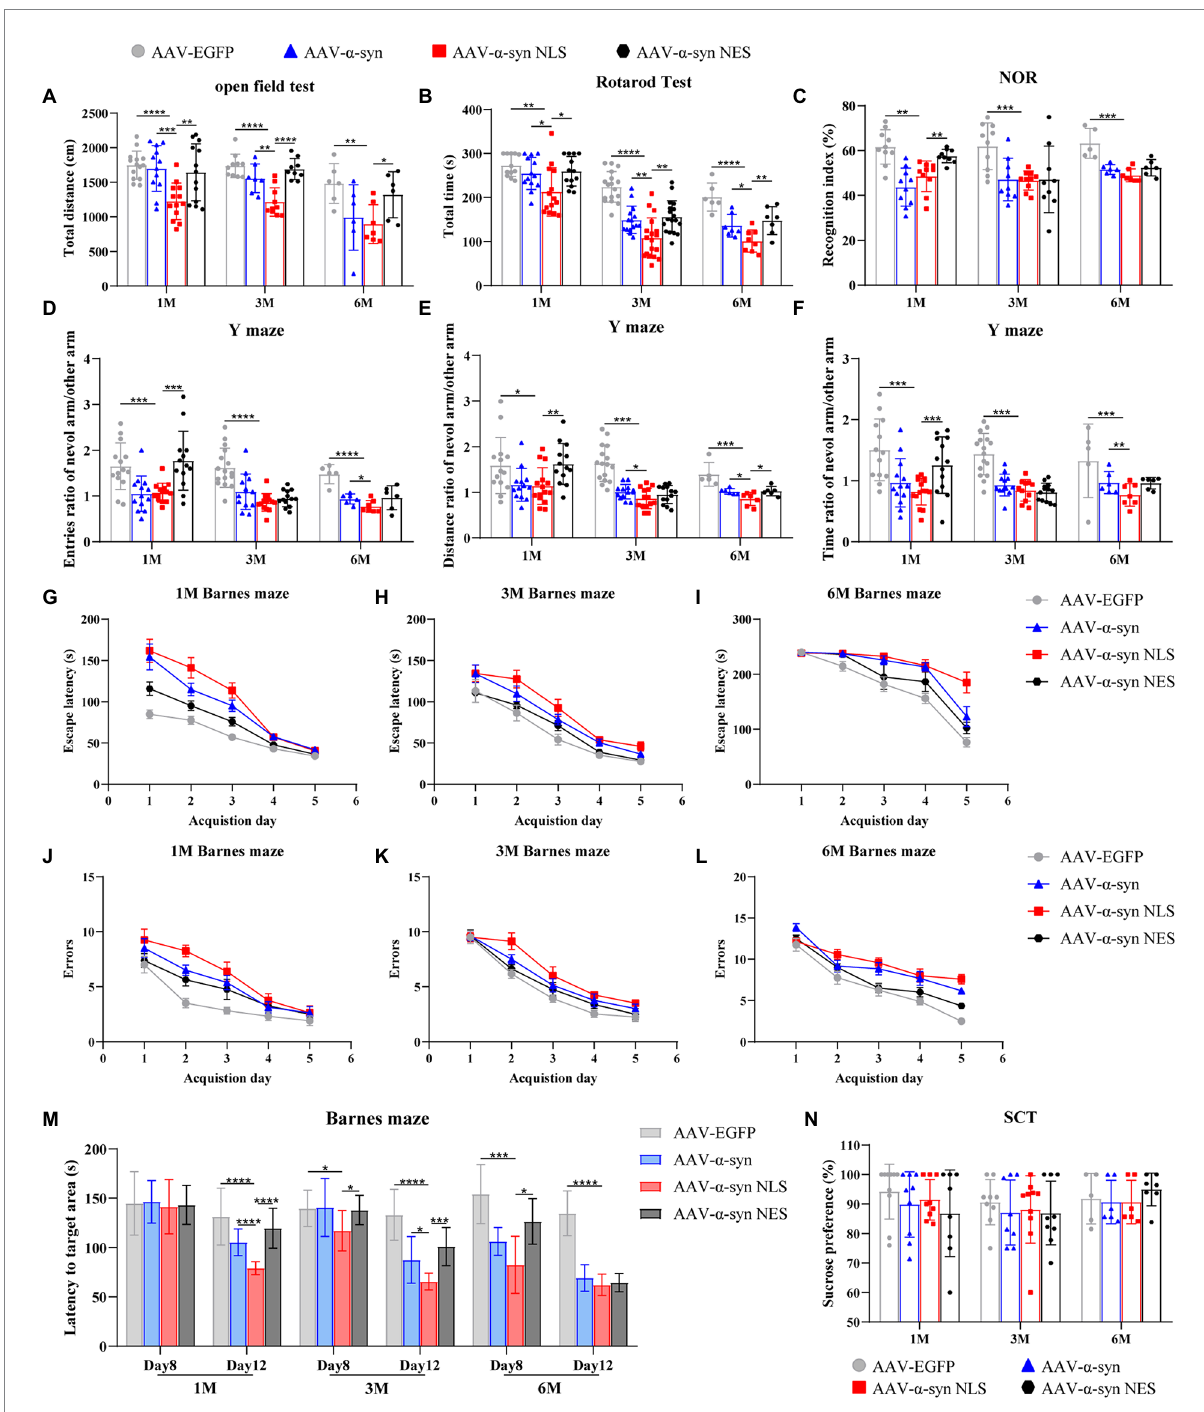
FIGURE 2 Overexpression of α -syn in hippocampal neuron nuclei causes motor impairment and spatial memory impairment in mice. (A) Statistical graph of horizontal total distance in the open-field test ( n = 15). (B) Statistical graph of duration in the rotarod test ( n = 15). (C) Statistical graph of recognition index in novel-object recognition (NOR; n = 15). (D–F) Statistical graph of the ratio of entries, distance, and time between the novel arm and other arms in the Y maze experiment ( n = 15). (G–I) Statistical graphs of escape time of mice entering the target box from the Barnes maze platform at different detection periods ( n = 12). (J–L) Statistical graphs of error times of mice before entering the target box at different detection periods ( n = 12). (M) Statistical graph of mouse exploration time in the quadrant of the target box after removing the target box from the Barnes maze ( n = 12). (N) Statistical graph of sucrose preference of the sucrose consumption test (SCT; n = 10). * p < 0.05, ** p < 0.01, *** p < 0.001, **** p <